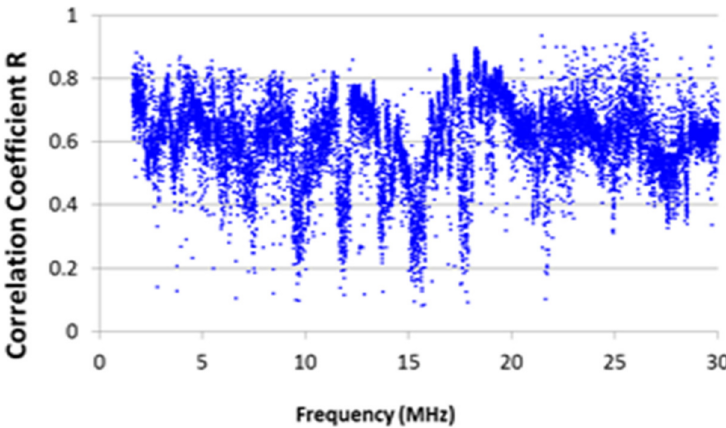
Figure 7. Correlation coefficient for signal strength measurements received in the same 1 kHz channel by low- and high-elevation HE016 antenna components plotted across the HF